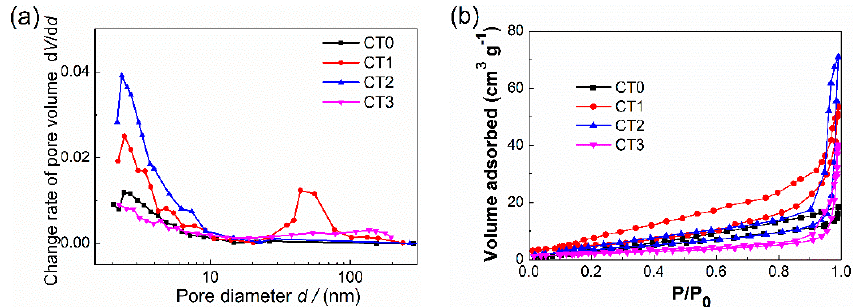
Figure 4. Pore structure characteristics of samples CT0, CT1, CT2, and CT3. ( a ) Pore size distributions; ( b ) Isothermal absorption and desorption curves.